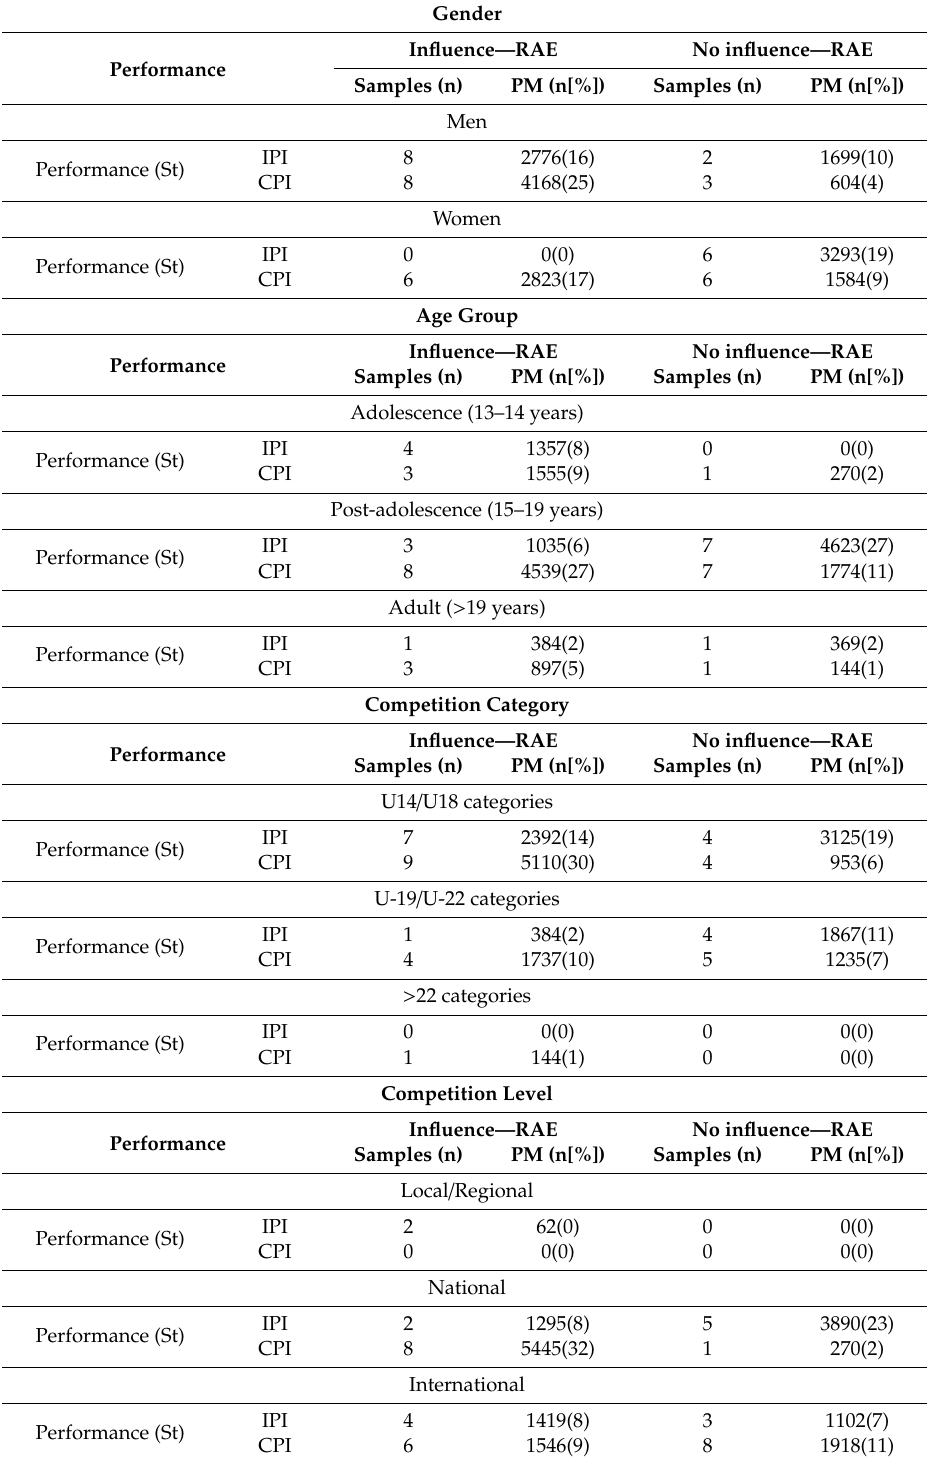
Table 4. Summary of samples (n) and performance measures—PM (n and [%]) within the relationship between the relative age e ff ect (RAE) and competition performance by characteristics of athletes (gender and age group) and sport context (competition category and competition